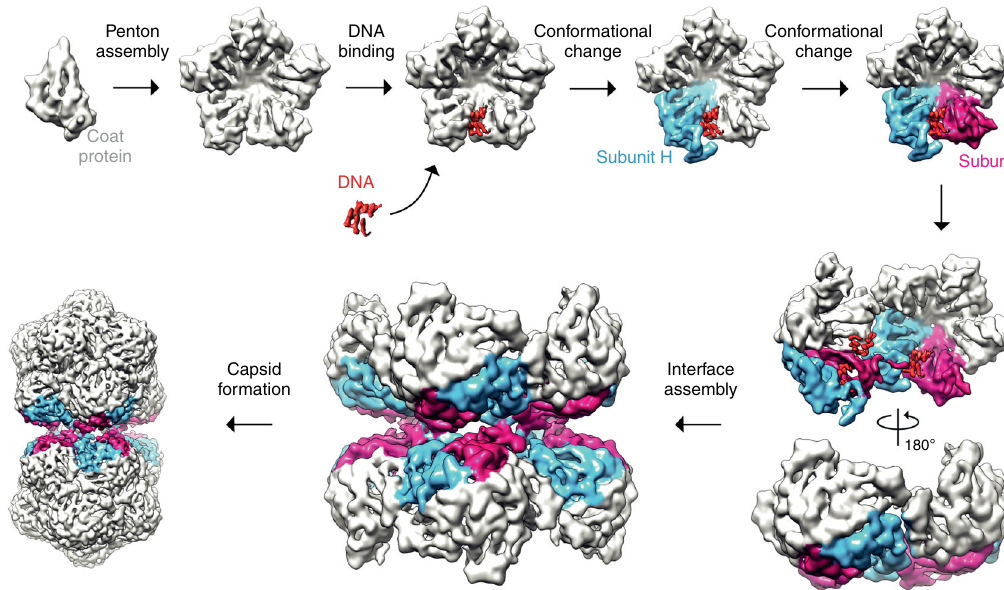
Fig. 6 A model of geminate particle assembly. Five CP subunits assemble into a penton, the building block of the geminate capsid. A DNA stem loop speci fi cally binds to the N terminus of a CP subunit triggering 23 amino acids in the N terminus to become ordered and adopt the chain H conformation (blue). The neighboring subunit also undergoes a conformational change where eight amino acids in the N-terminal become ordered and adopt chain I conformation (maroon). The combination of these conformational changes allows the interface of a geminate capsid to assemble at the equator. Finally, the hemicapsids are assembled by addition of CP